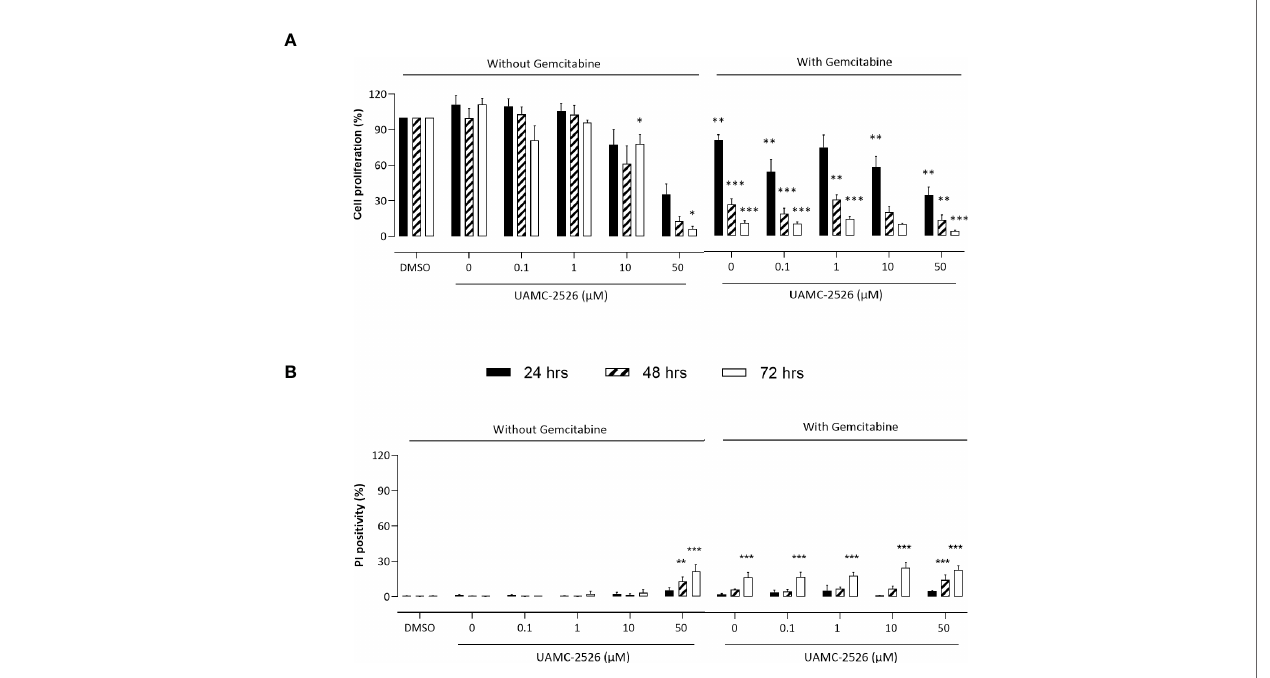
FIGURE 1 | UAMC-2526 inhibits Panc02 cell proliferation. (A) Panc02 cells were treated in vitro with different concentrations of UAMC-2526 in the presence or absence of gemcitabine (10 µM). Cell proliferation was measured at different time points with neutral red. Data were analyzed using one sample t-test. Six independent experiments were performed. After normalization, the resulting fold change was log transformed (log2-base) to obtain an approximately normal distribution. *p ≤ 0.05, **p ≤ 0.01, ***p ≤ 0.001 versus DMSO group. (B) Panc02 cells were treated in vitro with different concentrations of UAMC-2526 in the presence or absence of